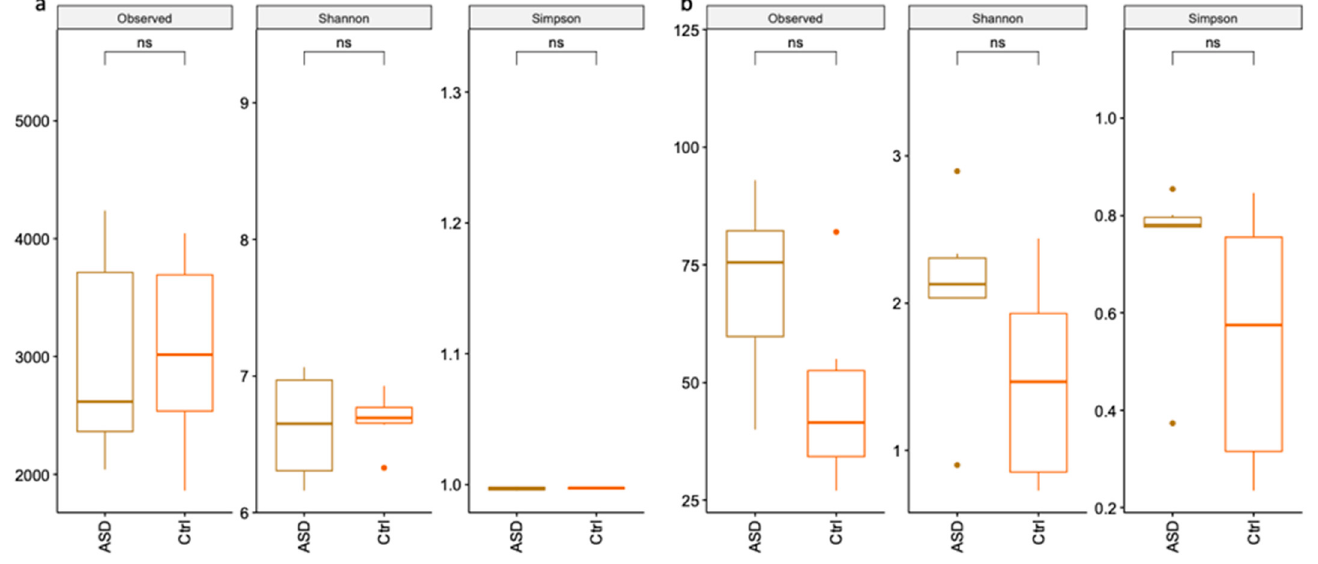
Figure 1. Alpha diversity analysis. Alpha diversity analysis with Shannon and Simpson indices of 16S ( a ) and 18S ( b ).